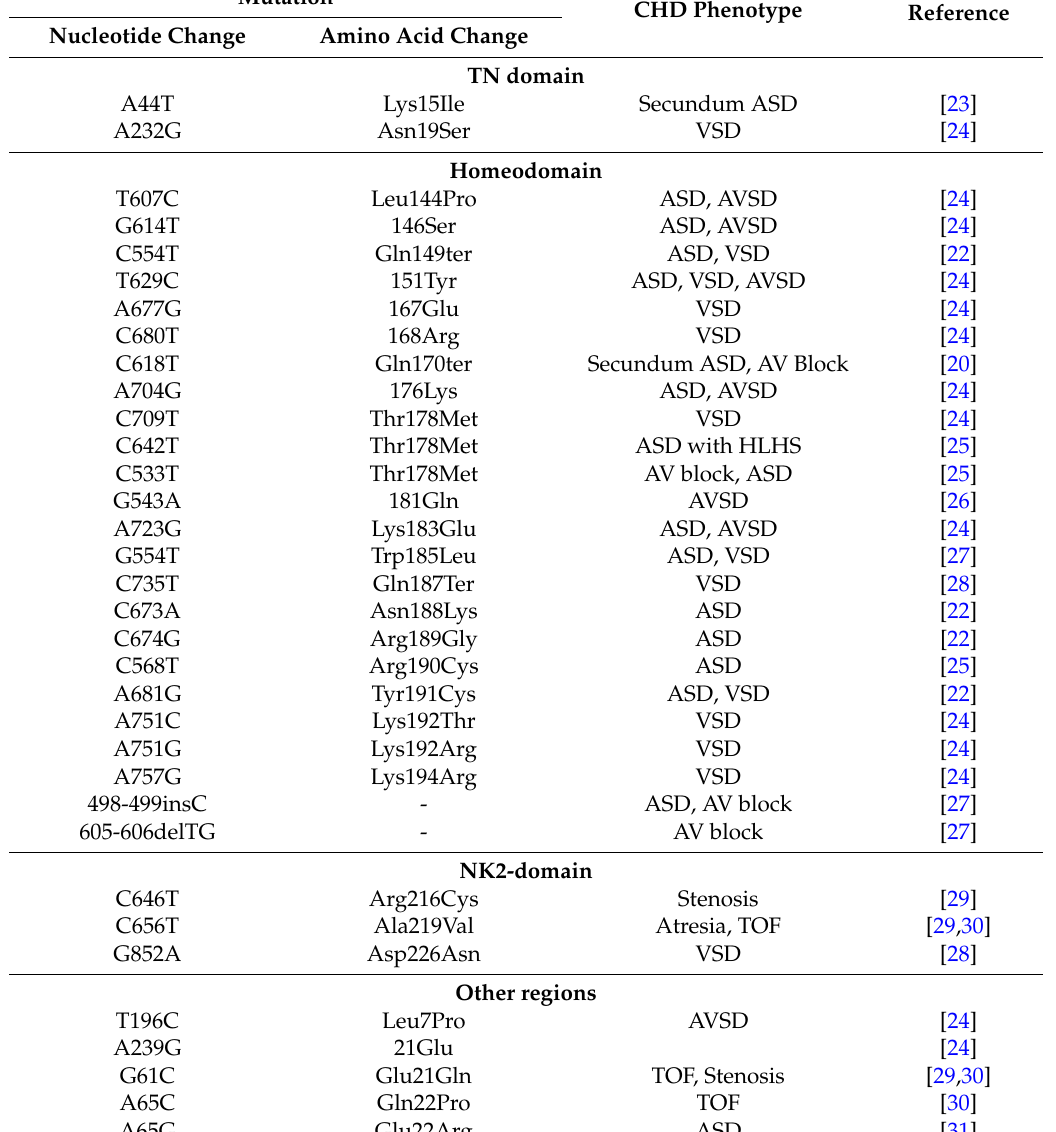
Table 2. List of NKX2-5 mutations reported in previous